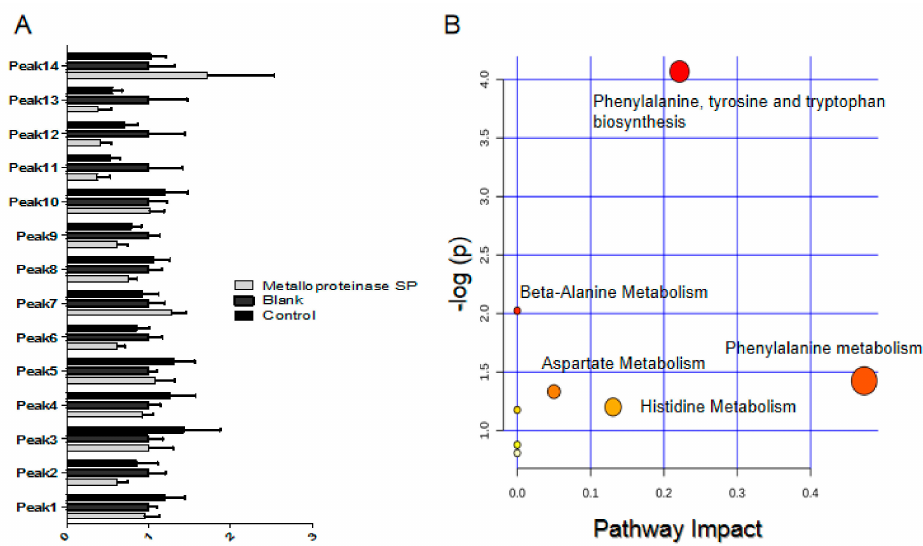
Figure 8. ( A ) Relative signal intensities for metabolic biomarkers in the blood. ( B ) Summary of pathway analysis with Metabo Analyst 4.0. Each ordinate in the plot represents a metabolic pathway. The ordinate is the original p -value obtained from the pathway analysis, and the abscissa is the influence value of pathways obtained from the topological analysis. The ordinate color and size of each circle was based on p -value and pathway impact value,